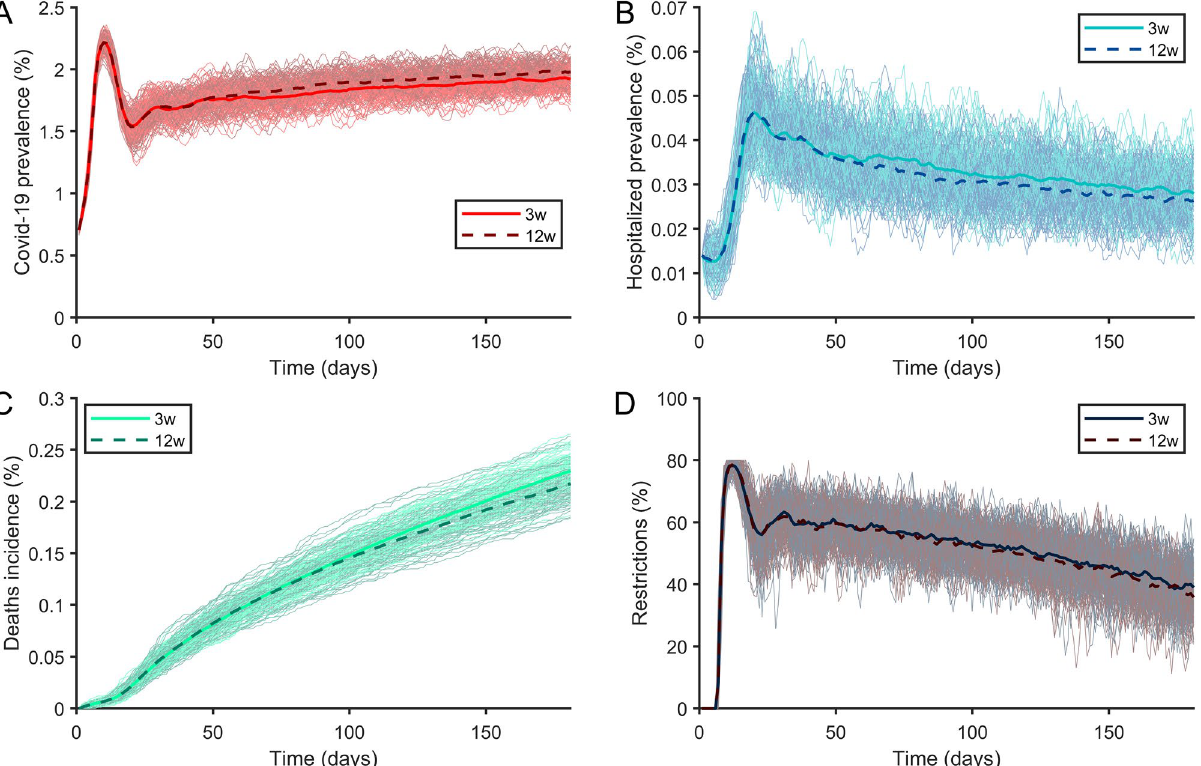
Figure 4. Outcomes of cumulative incidence of ( A ) infection, ( B ) hospitalisations, and ( C ) mortality, and ( D ) the resulting impact on public health restrictions using Oxford/AstraZeneca vaccine with between-dose intervals of 3 or 12 weeks. Each light curve is a single run of the same set of parameters, according to its colour. Each thick curve is the average of the 100 single